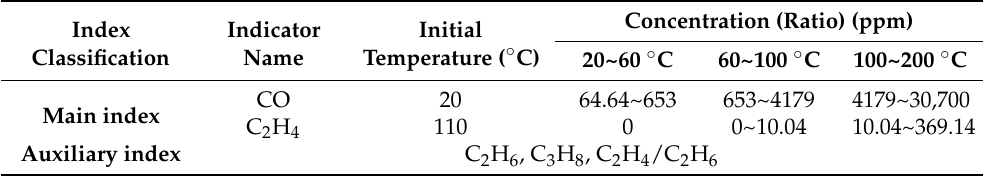
Table 6. Optimization results of coal seam SC index